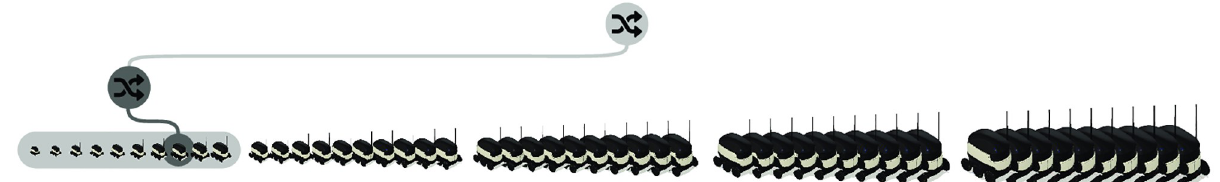
Fig 2. Robot selection during the back-off design phase of the experiment. For each participant, one robot is selected from each of five size clusters in a randomized order. This robot will not be available to subsequent participants until all robots have been selected. The order of occurrence of size clusters is also randomized for each